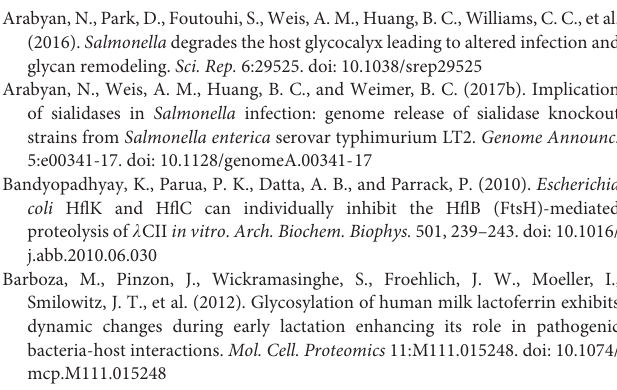
FIGURE S1 | Example of two 2D gels for non-reduced (A) and reduced (B) gels used to obtain protein spots for ID. Circled locations show areas that were a combination of bacterial and host proteins. Numbers indicate specific spots that were picked for ID. Comparing those locations between gel (A) and gel (B) indicated that those were cross-linked and released in reducing conditions. FIGURE S2 | Phylogenetic tree of amino acid sequences alignments of CdpA and its homologs. Phylogenetic tree of amino acid sequence alignments of CdpA, Lba0222, and homologs. Asterisks indicate the proteins identified in cross-linking assay. FIGURE S3 | Unique cdpA gene neighborhood structure and CdpA protein network analysis. (A) Functional protein network prediction of CdpA and LBA0222. Each unique protein network partner is indicated by a colored sphere. Blue lines joining each sphere indicate predicted partnership by text mining. Green lines joining each sphere indicate predicted partnership by gene neighborhood. (B) cdpA gene neighborhood is indicated by the colored tabs next to Lactobacillus acidophilus . Gene neighborhood uniqueness is indicated by the absence of similar tabs next to surrounding species and genera. FIGURE S4 | LBA0222 and CdpA (LBA0223) protein domain analysis. Dark and light purple arrows indicate operon membership. Domain analyses are listed in the tables below each gene. TABLE S1 | PCR primer sequences used in this